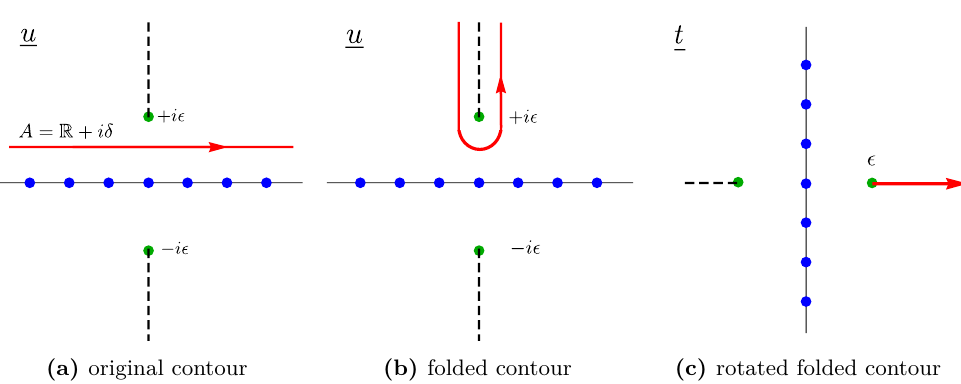
Figure 1. To arrive at the character integral from the Hubbard-Stratonovich trick, we fold the contour A (red) along the branch cut from (2.10) with branch point + i(cid:15) (green dot), and then rotate u = it . The blue dots represent the poles of f ( u )